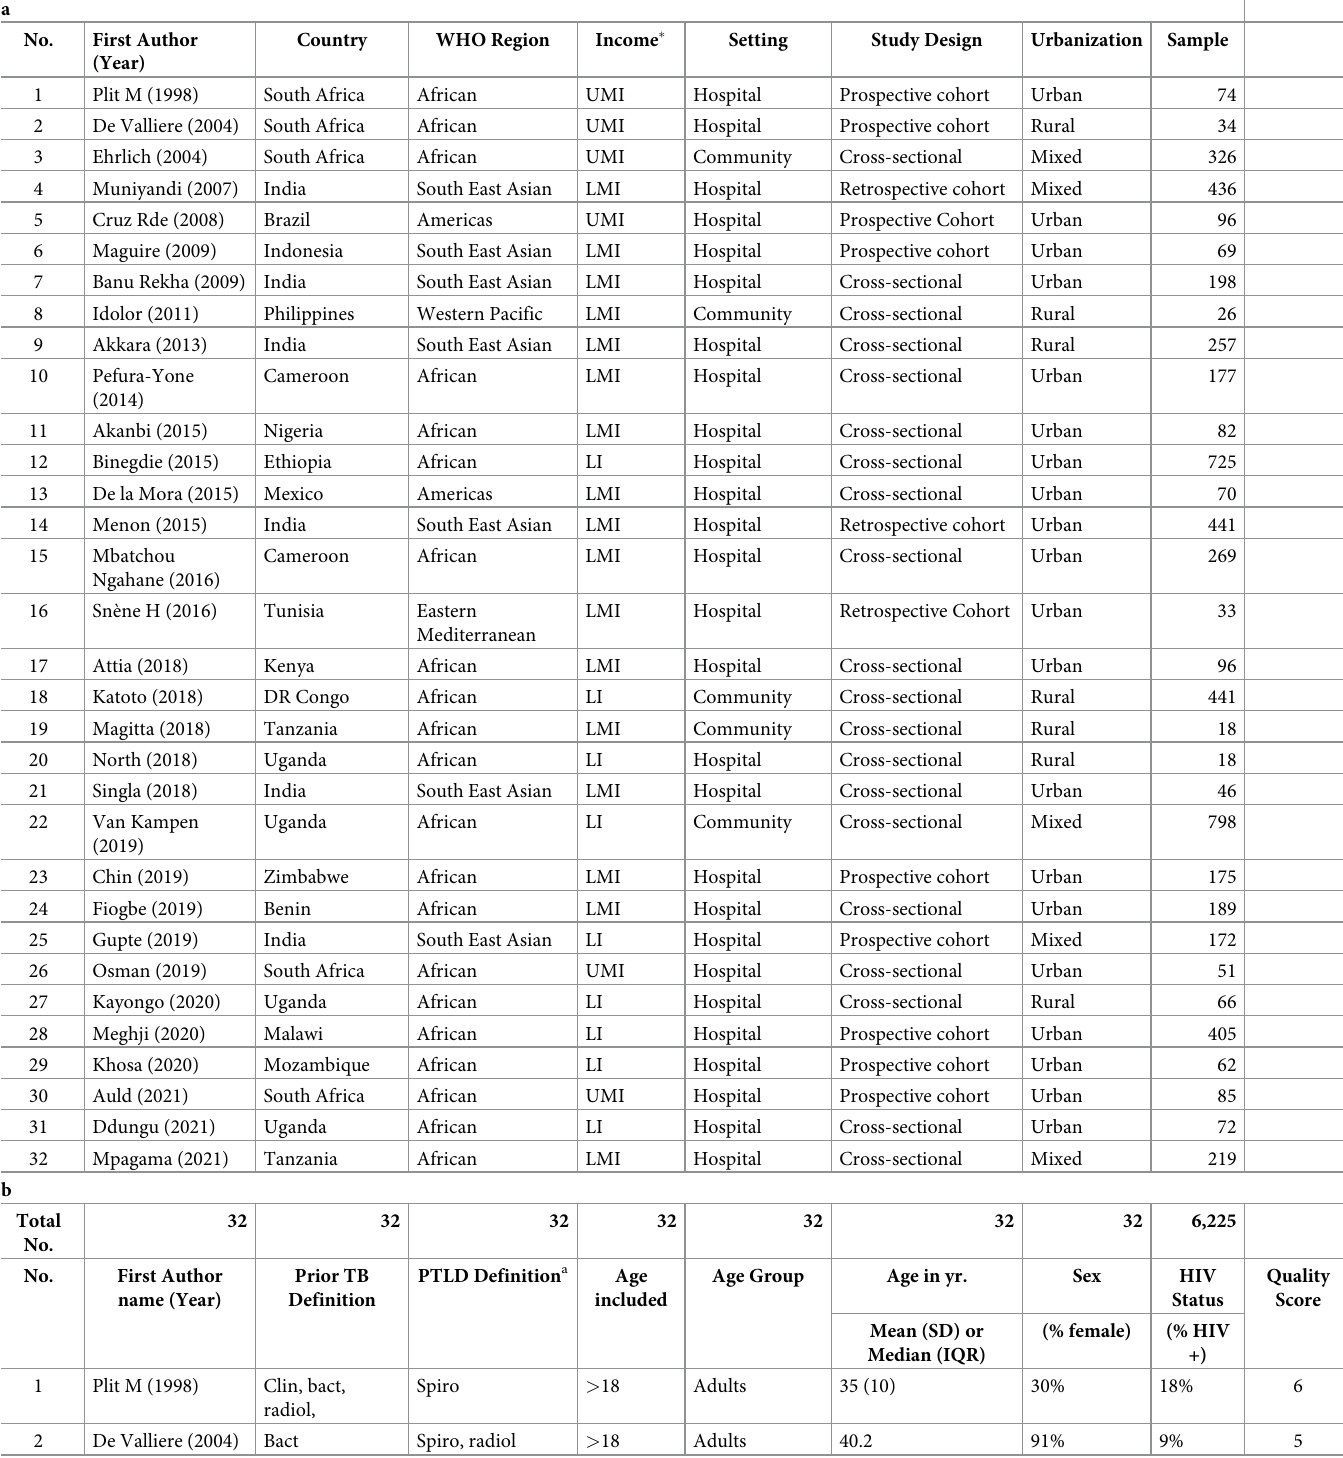
Table 1. a: Characteristics of included studies—geographic distribution, income level, study design, setting and sample size. b: Characteristics of included studies–diag- nostic criteria for prior TB and post-TB lung disease; age, sex, and HIV status of study